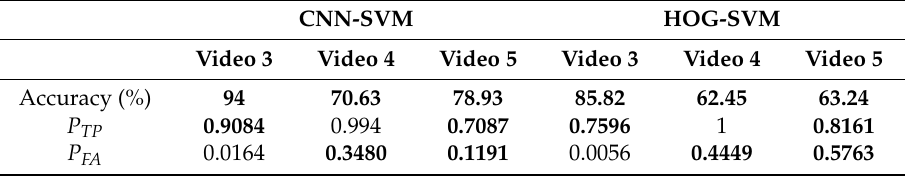
Table 13. Comparison of HOG and CNN feature extraction methods for the second